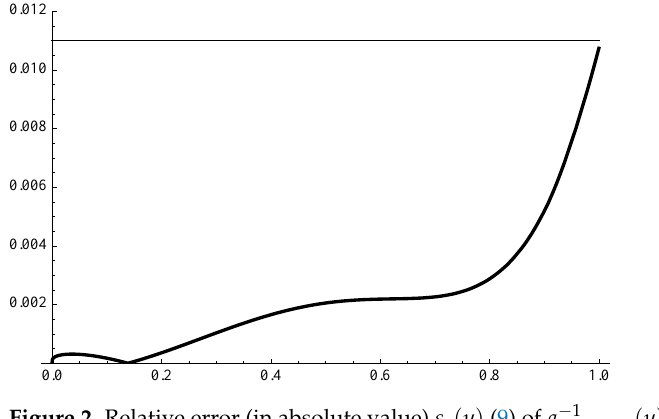
Figure 2. Relative error (in absolute value) ε r ( y ) (9) of a − 1